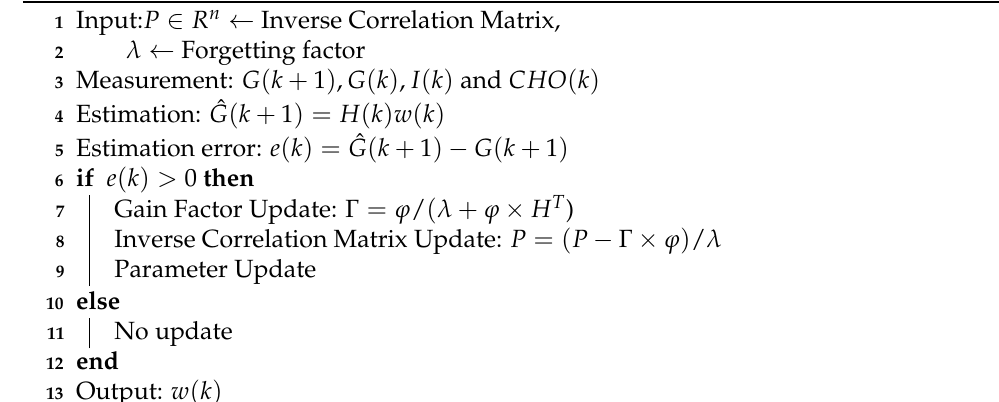
Algorithm 1: Dynamic Patient Model Parameter Estimation for BGL Prediction.